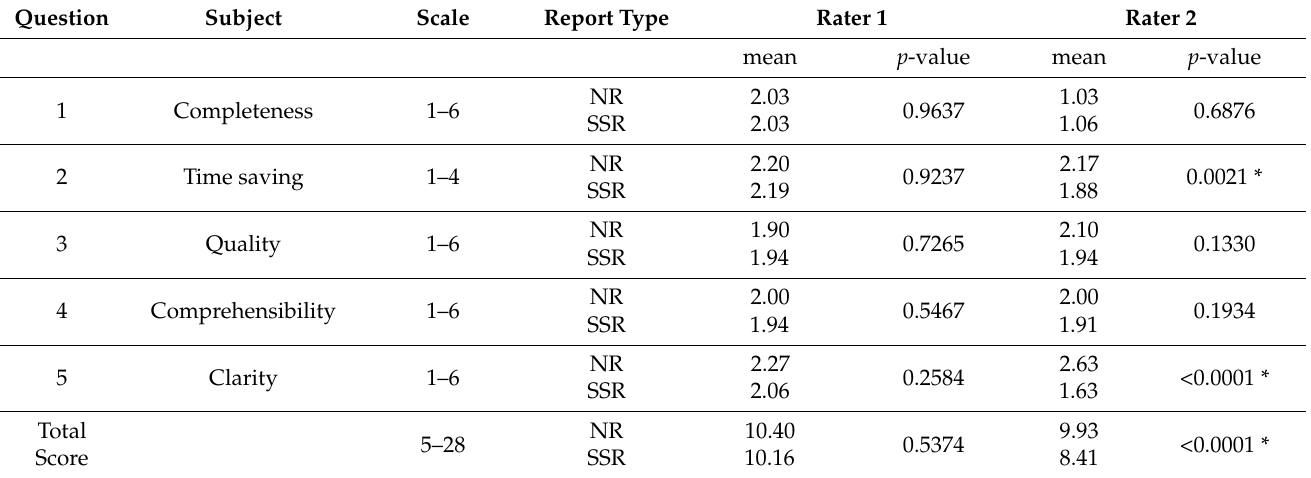
Table 4. Summary of questionnaire evaluation showing mean scores for all narrative (NR, n = 30) and standardized structured reports (SSR, n = 32) by the two board-certified urologists (rater 1 and 2). The two-sided t -test was performed to compare NR and SSR. p -values < 0.05 were considered statistically significant and are marked with an